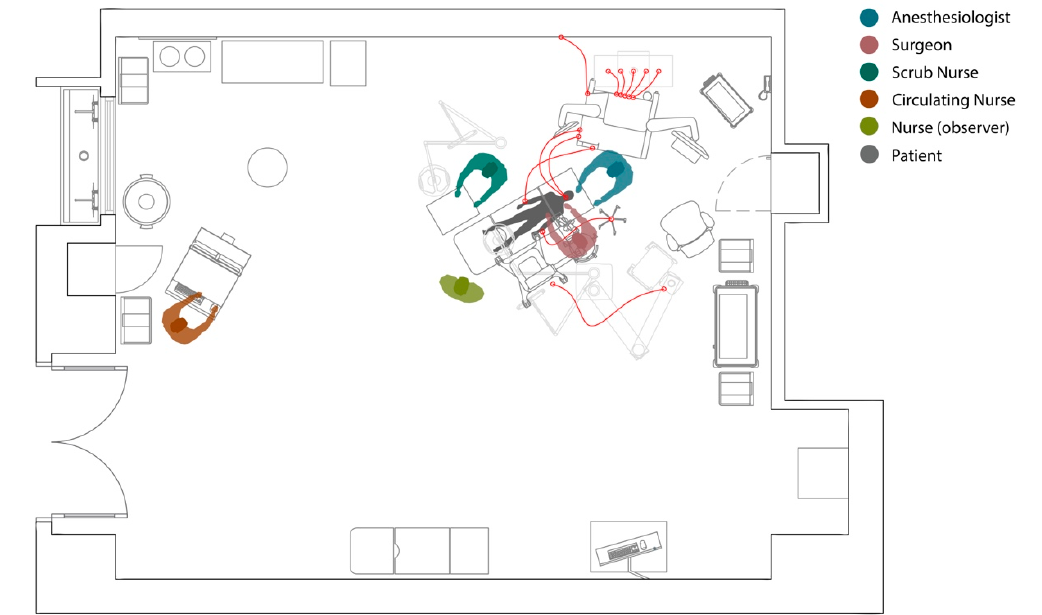
Figure 1. Multiple connections between the patient and OR equipment making surgical table rotations complicated and challenging.